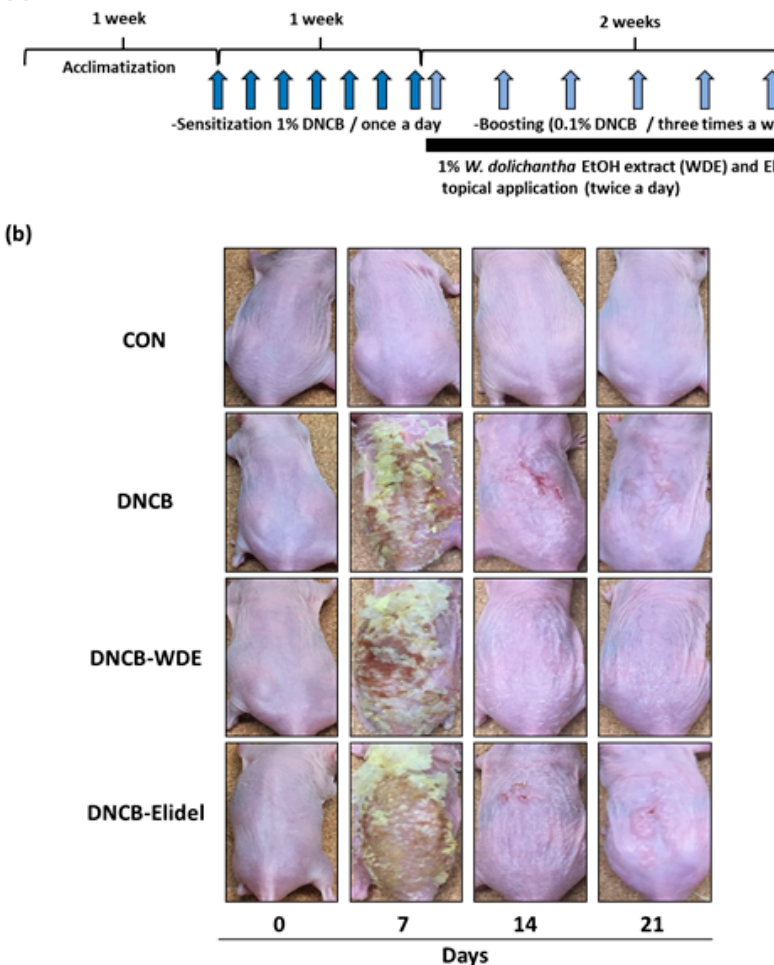
Figure 3. Effects of WDE on the development of DNCB-induced AD-like symptoms in hairless mice. ( a ) Schematic representation of the experiment. ( b ) Clinical features of AD-like skin lesions. WDE: EtOH extract of Wikstroemia dolichantha , CON: vehicle control group, DNCB: DNCB-treated group, DNCB-WDE: DNCB and 1% WDE-treated group, DNCB-Elidel: DNCB and 1% Elidel-treated group.